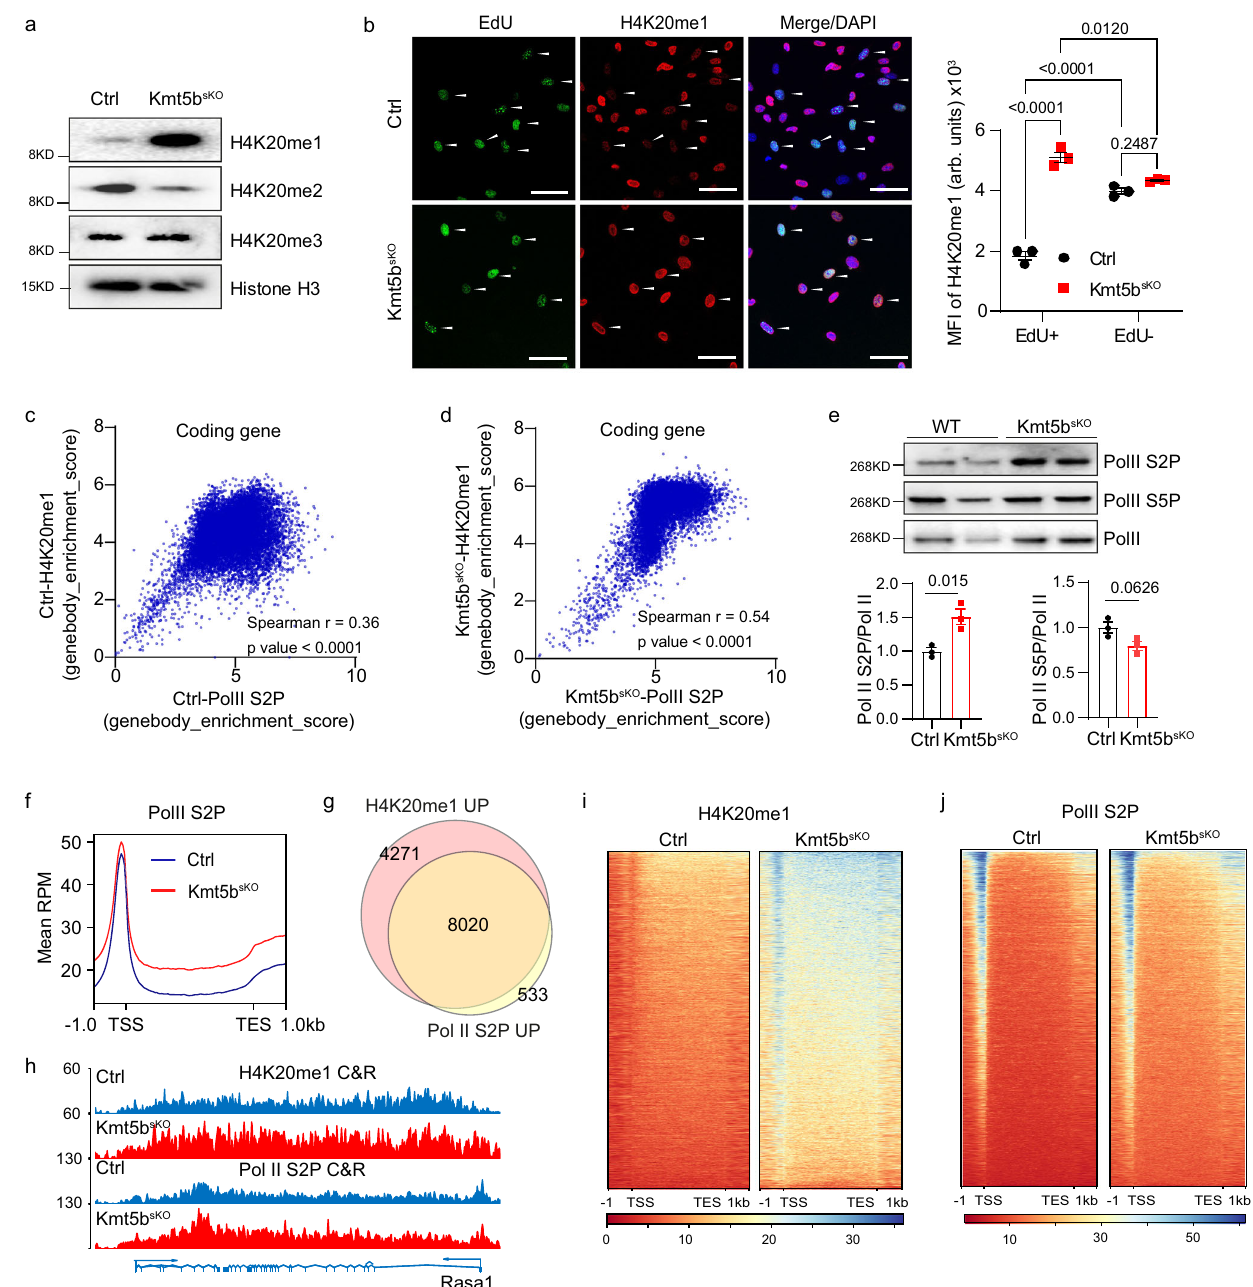
Fig. 2 | Inactivation of Kmt5b increases accumulation of H4K20me1 and occu- pancy of Pol II S2P on genes in S-phase. a Western blot analysis of histone H4 lysine 20 methylation in proliferating Ctrl and Kmt5b sKO MuSCs. Histone H3 was used as loading control ( n =2 mice). b Immuno fl uorescence analysis of EdU incorporation and H4K20me1 enrichment in Ctrl and Kmt5b sKO MuSCs after 3-days in culture. DNA was stained by DAPI. Cells in S-phase (EdU + ) are indicated by arrowheads.Scalebar:10 μ m.Medianof fl uorescenceintensity(MFI,arbitraryunits (arb.units))ofH4K20me1inEdU + /EdU − MuSCsareshownontheright( n =3mice). Two-way ANOVA. c , d Scatter plot showing correlation of H4K20me1 enrichment and Pol II S2P binding within gene bodies of Ctrl ( c ) or Kmt5b sKO ( d ) MuSCs. Spearman ’ s correlation coef fi cient r values are indicated. Two-tailed P -values indicate thesigni fi cance of thecorrelationdetermined by r valuesand samplesize. e Western blot analysis of Pol II S2P and S5P in proliferating Ctrl and Kmt5b sKO